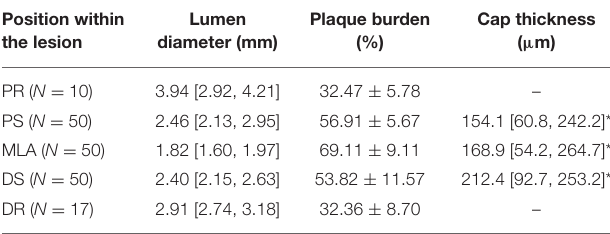
TABLE 1 | Baseline demographic characteristics.